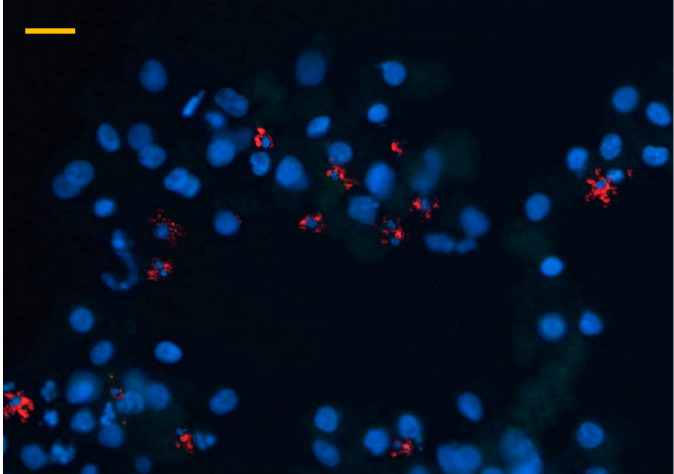
Figure 3. Immunofluorescent detection of macrophages in a hepatocyte—nonparenchymal cell co-culture after 48 h culturing with a phycoerythrin (PE) coupled chicken macrophage specific antibody (40× magnification, bar = 40 µm). Blue colour indicates cell nuclei with DAPI staining, while red colour refers to macrophages detected with the PE conjugated antibody.